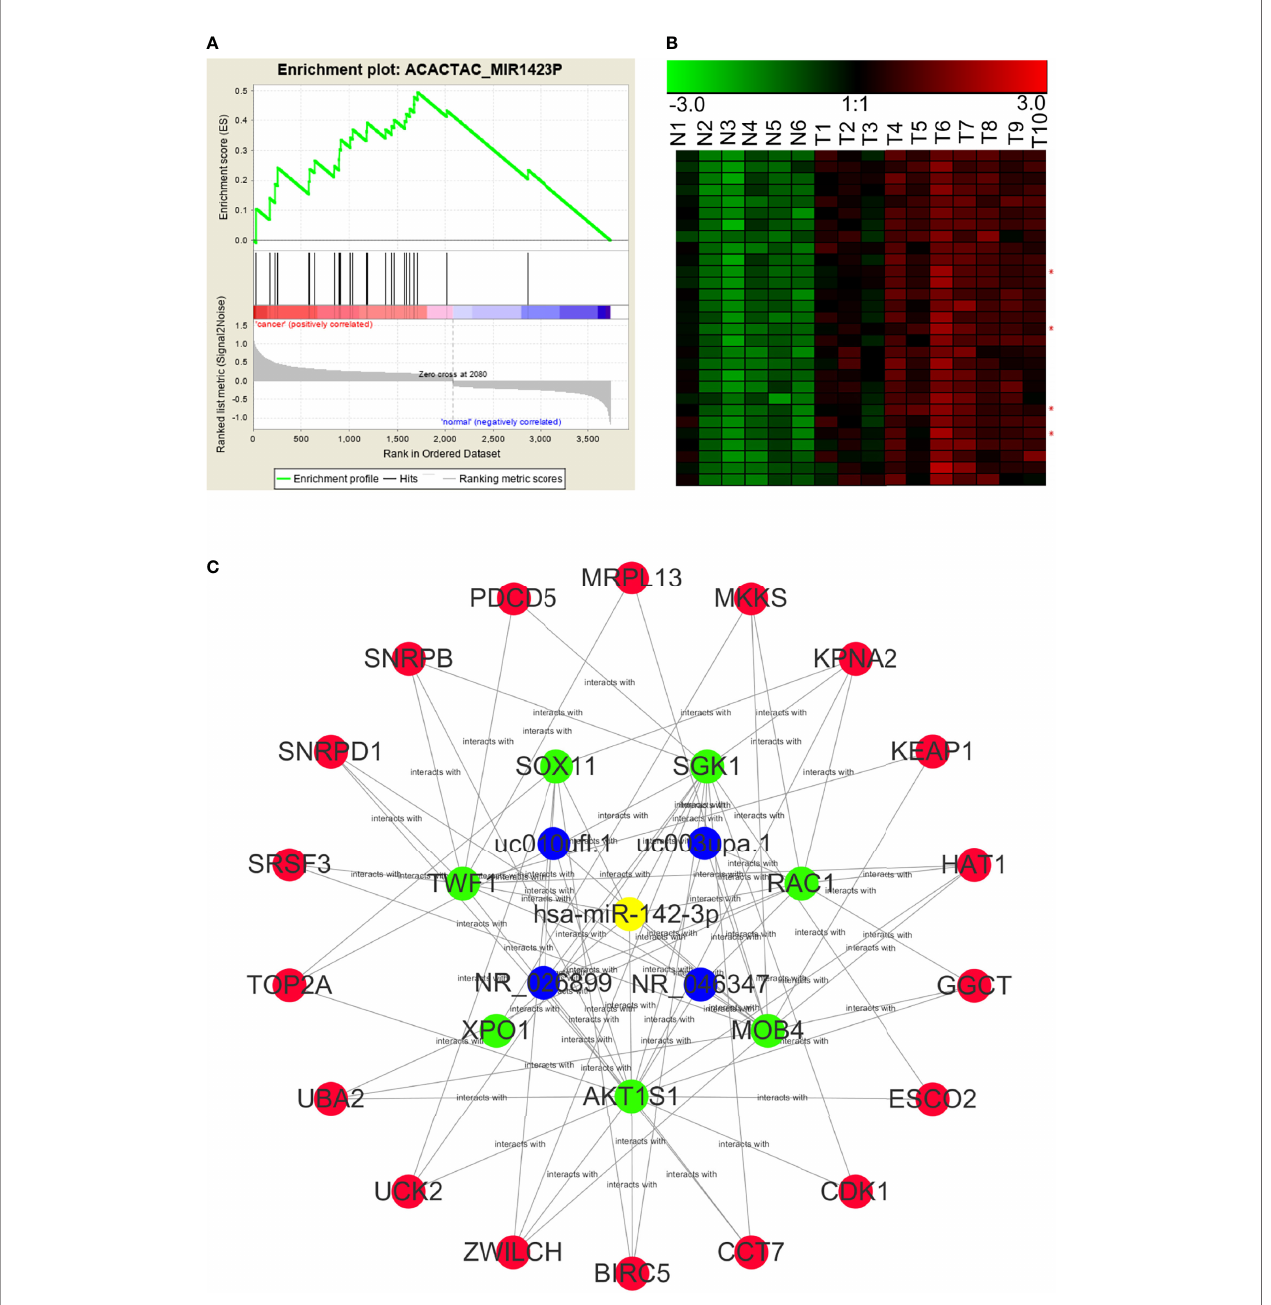
FIGURE 6 | A potential NPC lncRNA – mRNA ceRNA module based on the competition for miR-142-3p. (A) GSEA predicted that miR-142-3p target genes were signi fi cantly enriched among the RNAs that were differentially expressed in NPC. (B) Expression pro fi les of lncRNAs and mRNAs that may be targeted by miR142-3p in NPC (red asterisks indicate lncRNAs). N, the nasopharyngeal epithelium; T, nasopharyngeal carcinoma. (C) An NPC lncRNA – mRNA regulatory module based on the competition for miR142-3p, constructed through GSEA and